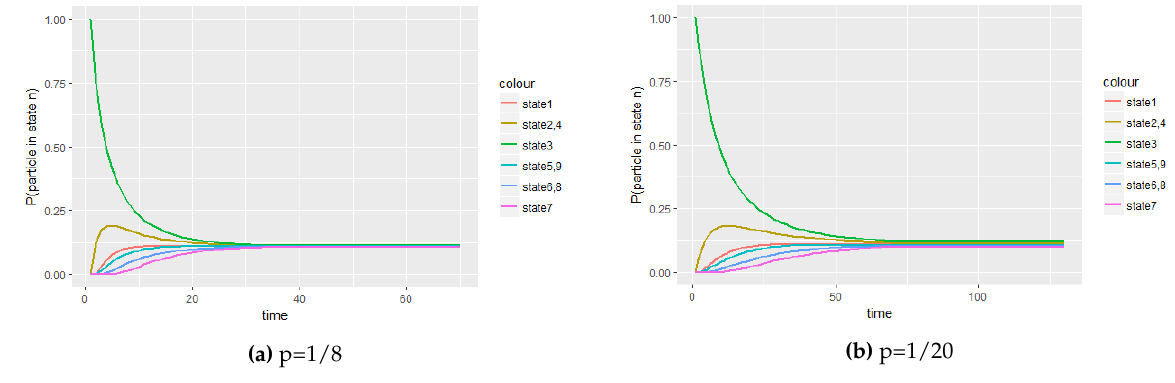
Figure 14. The panel of graphs to represent transitional probabilities against time interval of a transition matrix P with starting point at the one of the side cells, that is North-South or East-West of the central cell with with = ( 0,0,1,0,0,0,0,0,0 ) . From these figures state 2 and 4, 5and 9, 6 and 8 overlaps initial probability vector P 0 3 together to form new states respectively because they have the same stochastic behavior to the